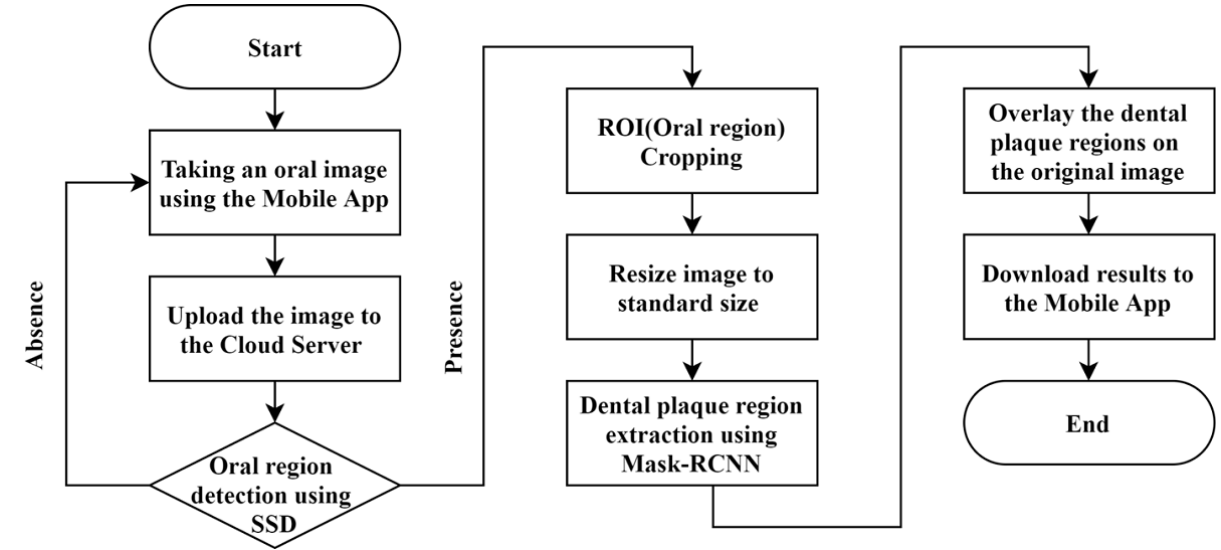
Figure 4. Flowchart of oral hygiene